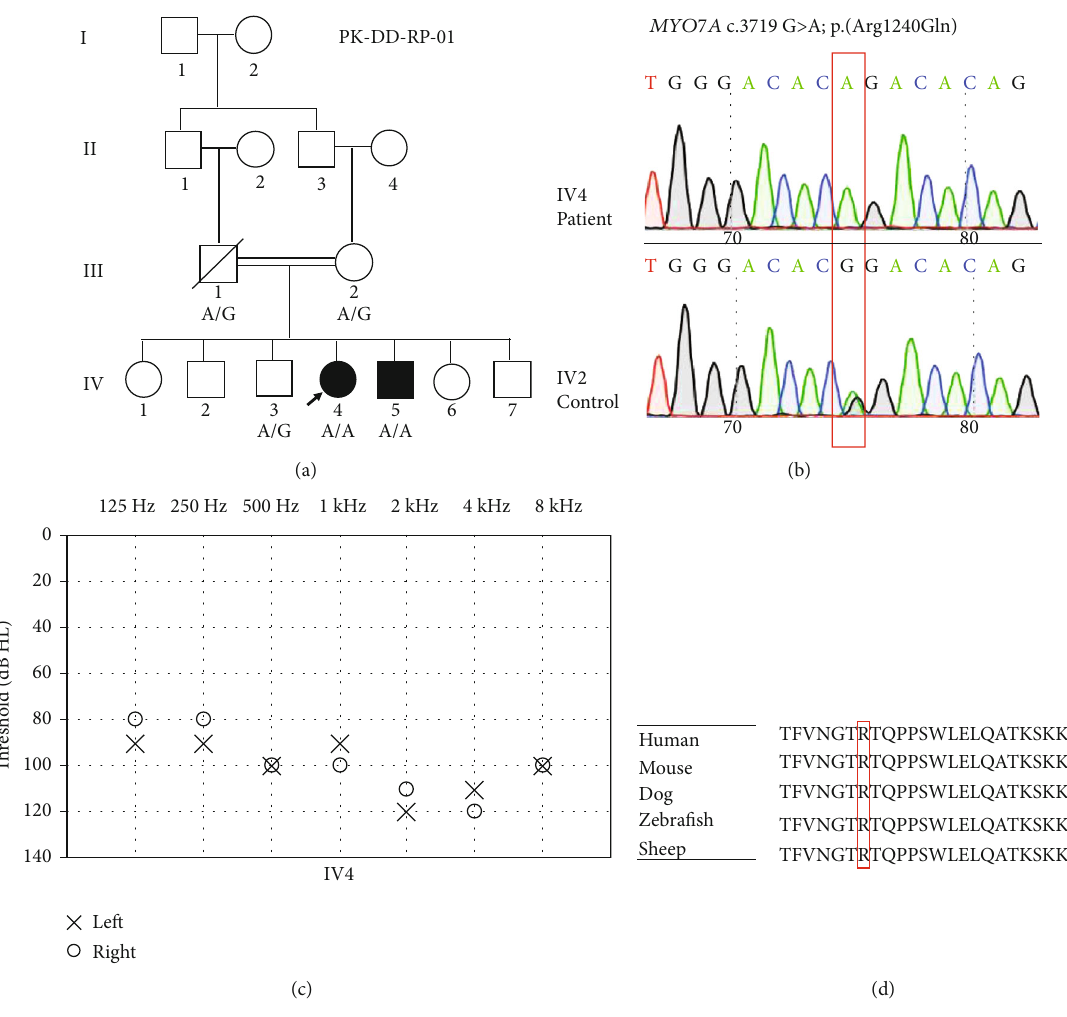
Figure 2: Genetic and phenotypic characterization of Family PK-DD-RP-01. (a) Pedigree and genotype showing the c.3719 G > A (p. Arg1240Gln) variant in MYO7A . (b) Sanger sequencing of the c.3719 G > A (p. Arg1240Gln) variant in a ff ected and una ff ected family members. (c) Pure tone audiometry showing the bilateral profound hearing loss in a ff ected family member IV-4. (d) Multiple sequence alignment showing the conservation of the R1240 residue in di ff erent